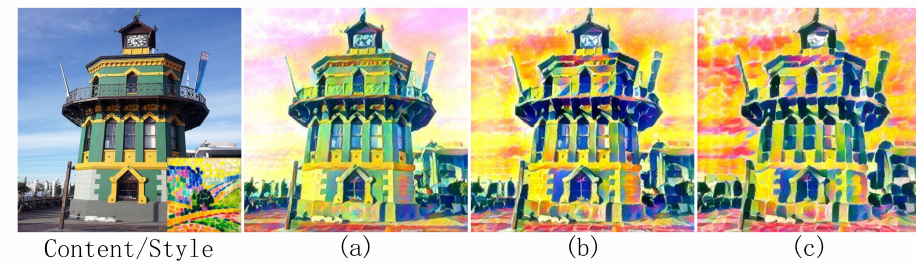
Figure 7. The effectiveness of using three HDAMA modules. ( a ) One HDAMA module; ( b ) two HDAMA modules; ( c ) three HDAMA